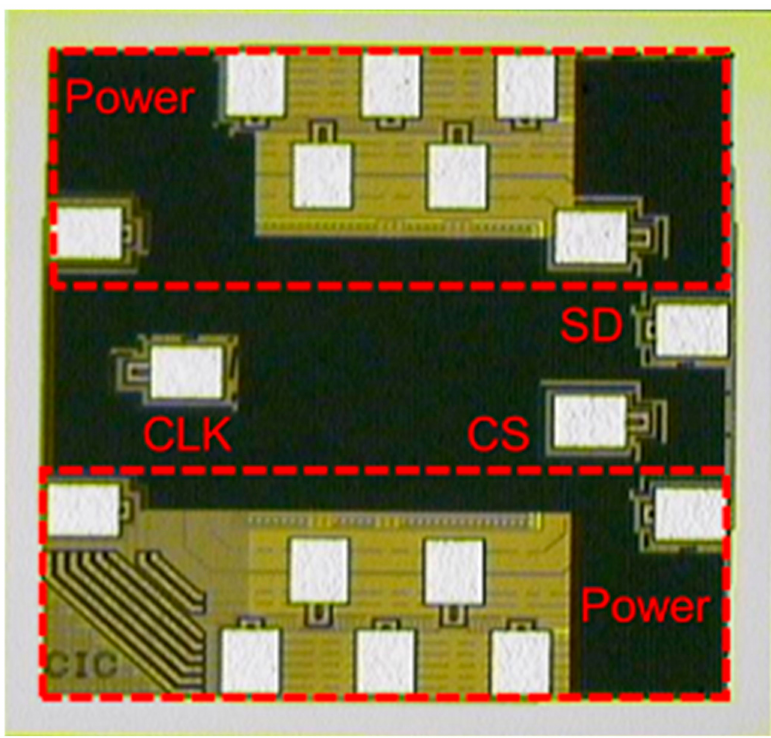
Figure 14. Fabricated chip view of the two-wire low-power synchronous preamble data line ASIC design through an optical